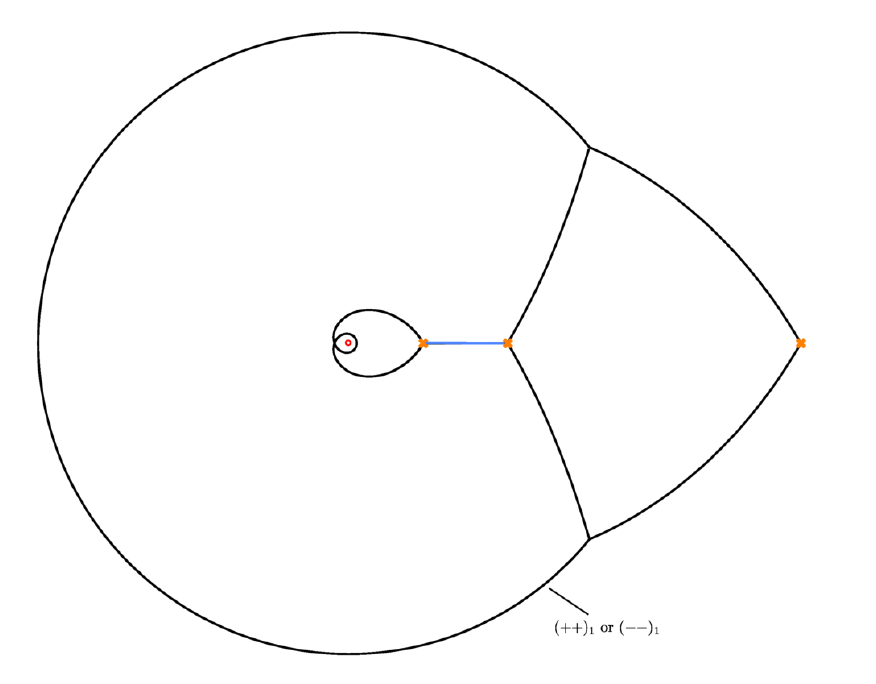
Figure 44. Network at # = 0 at a point in moduli space where the D4- and D0-brane coexist. The blue segment is the D4-brane. The inner loop, along with the outer (cid:12)nite web for either choice of (++) or ( (cid:0)(cid:0) ), constitute the three (cid:12)xed points of the D0-brane.